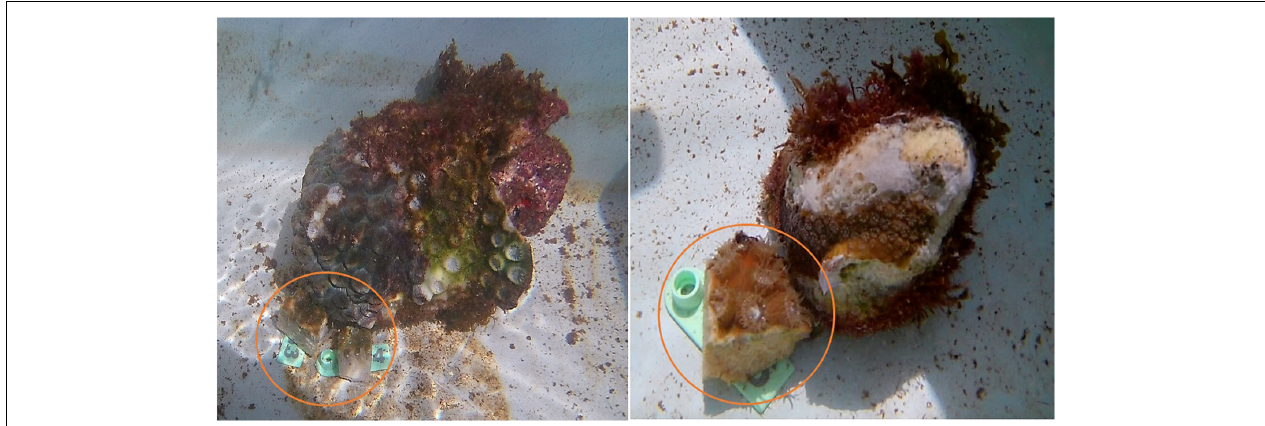
FIGURE 1 | The coral fragments circled in orange are Montastraea cavernosa fragments (fMCAV) that were placed in direct contact with a donor diseased corals to induce infection and study direct contact transmission rates.